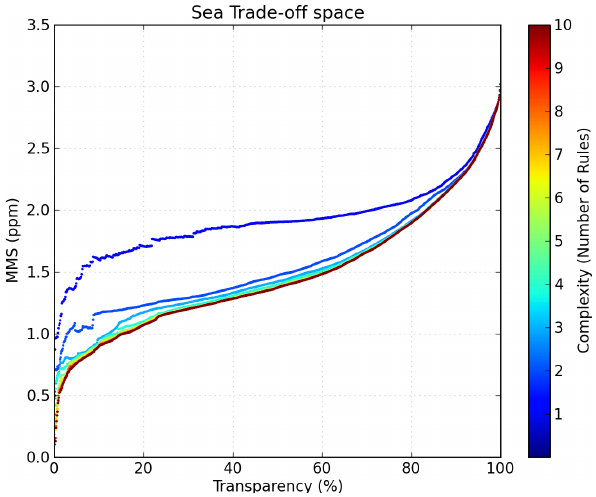
Figure 8. The Pareto optimal trade-off curves for dominant Sea fixed filters in the southern 2 Fig. 8. The Pareto optimal trade-off curves for dominant Sea fixed hemisphere using all available features. Note that beyond a complexity of three, there is little 3 filters in the Southern Hemisphere using all available features. Note filtration improvement. 4 that beyond a complexity of three, there is little filtration improve-